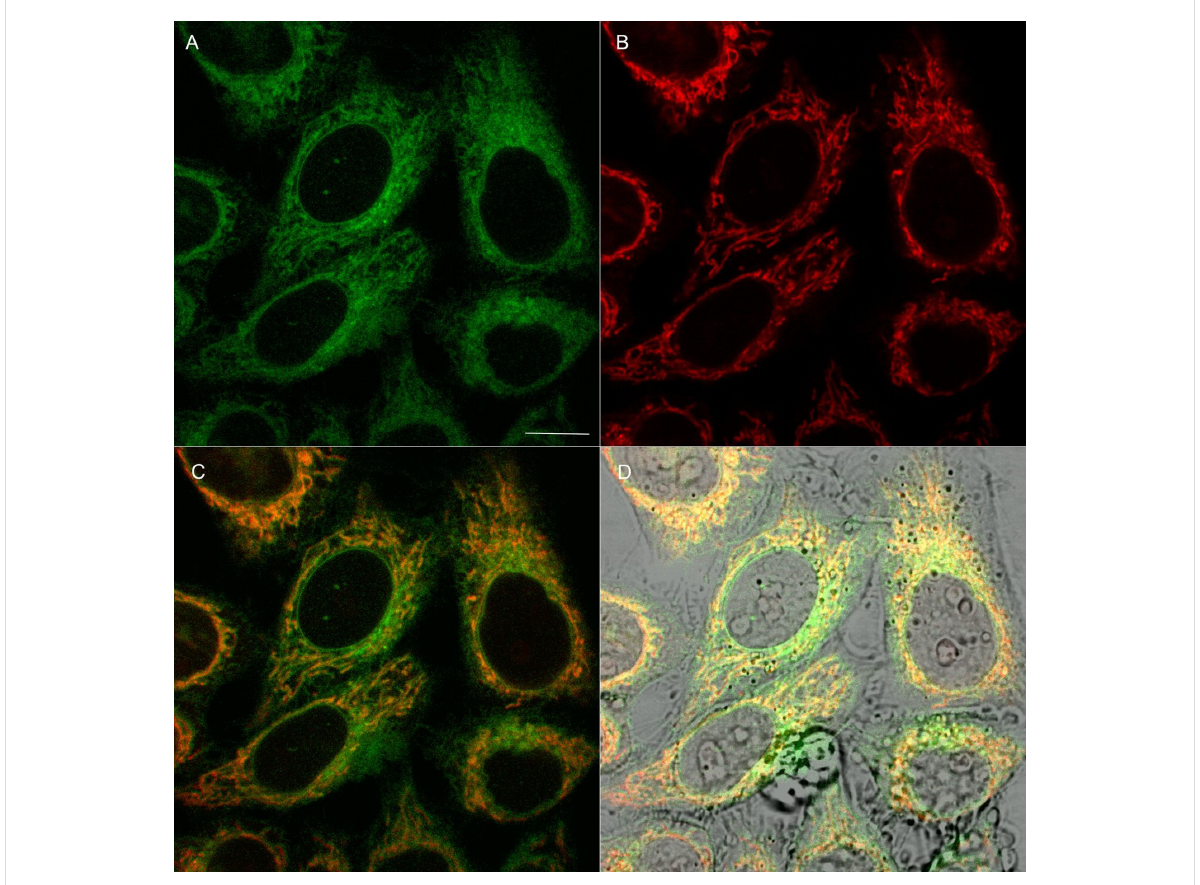
Figure 6: Cellular distribution of 4 in living HeLa cells. (A) Fluorescence of 4 (green). (B) Fluorescence of mitochondria-specific MitoTracker Red ® (red). (C) Merged image of 4 (green) and MitoTracker (red). (D) Merged image of (C) and transmitted light (gray). Scale bar – 10